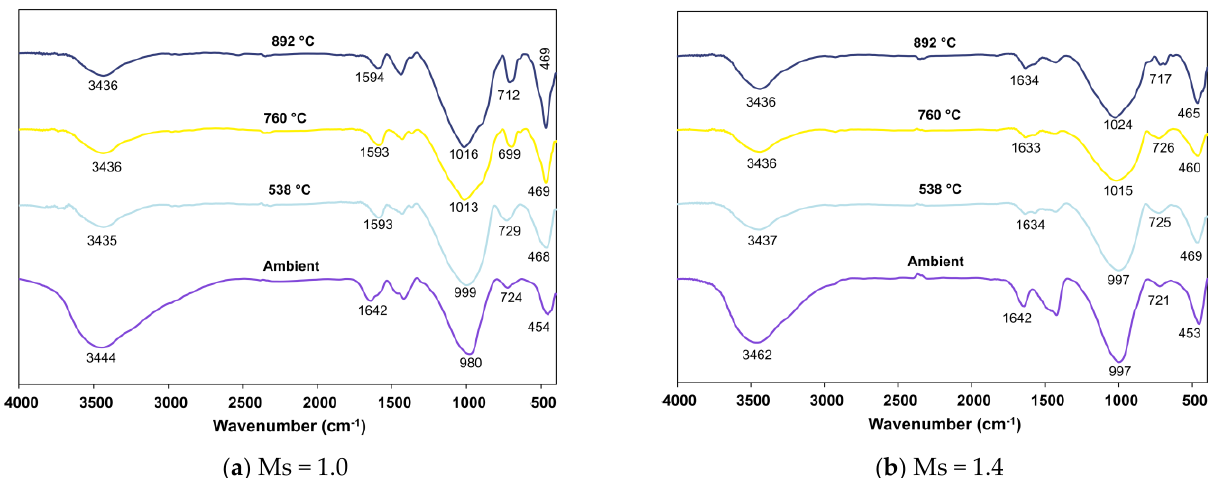
Figure 13. FTIR spectra of FS 50P on exposure to elevated temperature.